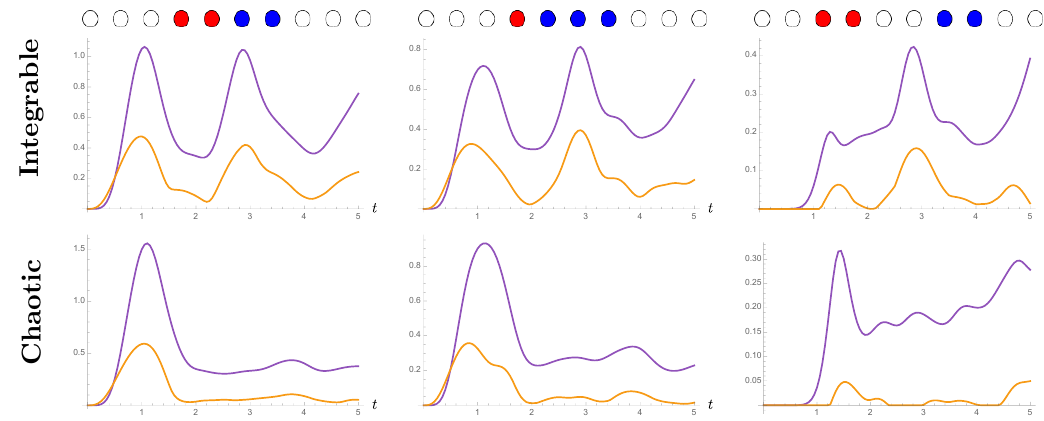
Figure 13 . Numerical simulations of a global quench are shown for both integrable and chaotic quench Hamiltonians (3.47). We consider three con(cid:12)gurations: adjacent symmetric, adjacent asym- metric and disjoint. These are labeled by the red and blue dots at the top of the columns. We use a 10 spin chain and begin will all spins up in the z-basis. The purple and yellow curves correspond to the mutual information and logarithmic negativity